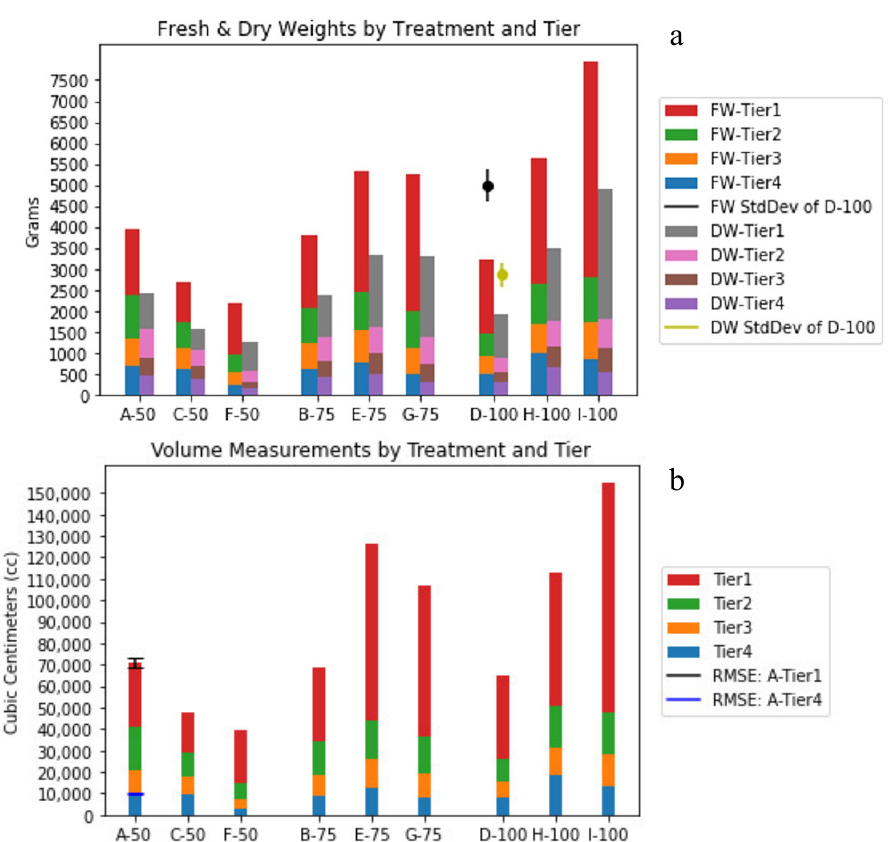
Figure 10. Individual value-stacked bar plots depicting the distribution of fresh weight ( a ), dry weight ( a ), and volume ( b ) along the quartered vertical profile of guayule. FW and DW arithmetic average of three samples and their standard deviation are illustrated for D-100. RMSE of volumetric measurements for tiers 1 and 4 are shown as error bars for A-50.